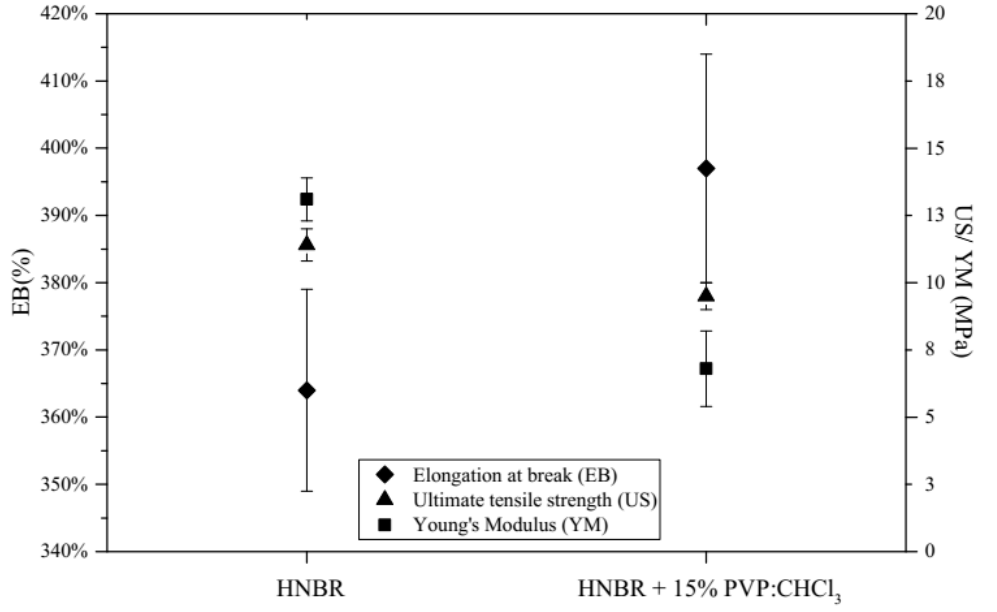
Figure 3. Elongation and break (left axis) and ultimate tensile strength and Young’s modulus (right axis) for pristine HNBR and HNBR immersion in 15% PVP:CHCl 3 for 15 min followed by air drying.